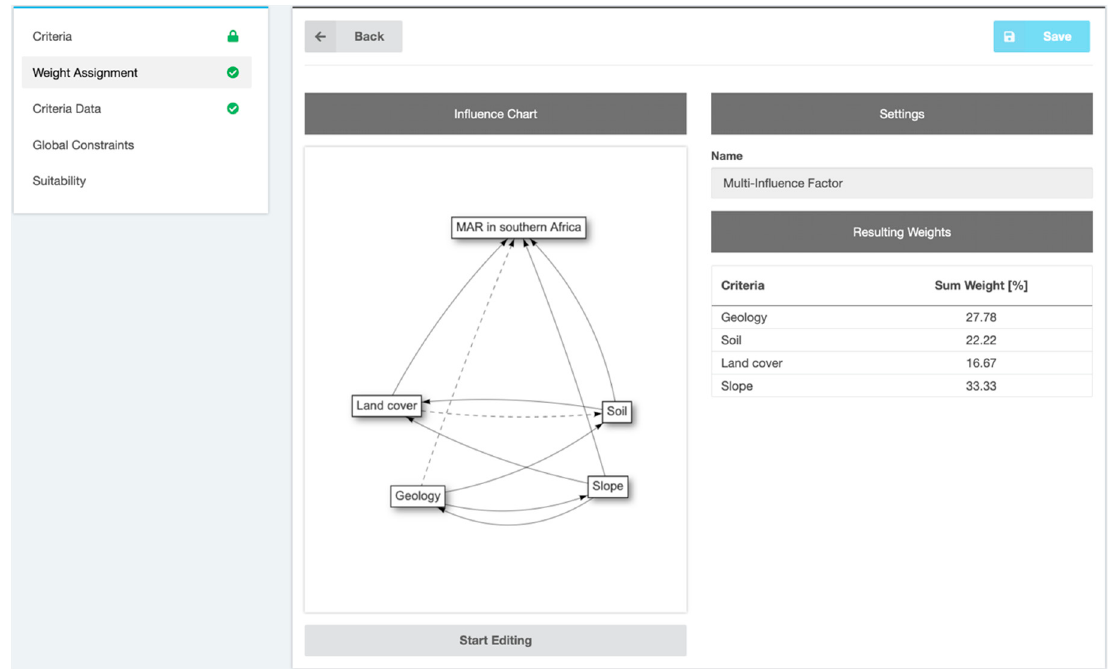
Figure 2. Interface of web GIS tool, with workflow display on the left and the weight assignment tool multi-influencing factor method. Here, the user can draw arrows between entities representing major or minor influences of a criterion upon another entity.